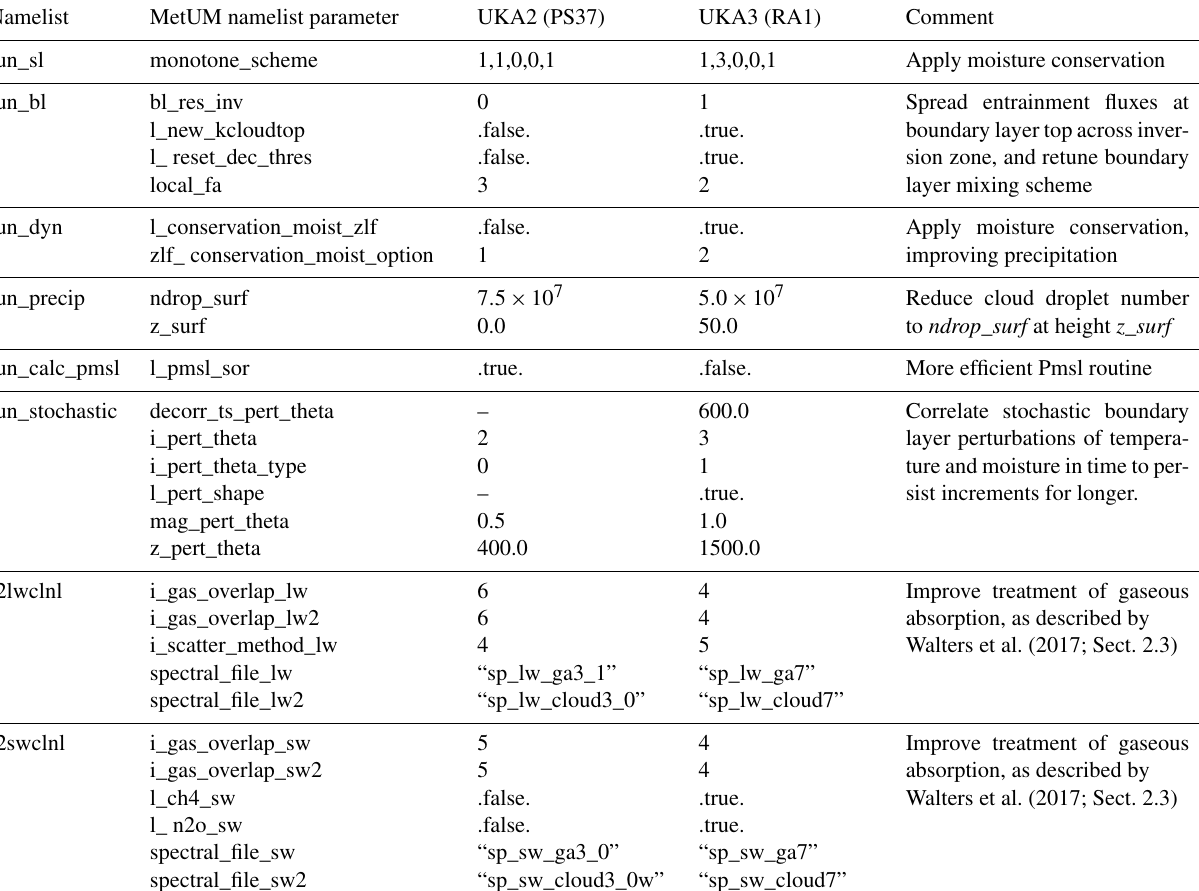
Table 5. Summary of key changes between UKA2 and UKA3 configuration MetUM namelists, associated with implementing enhanced science options based on regional atmosphere-only model development and evaluation. Registered MetUM users can access further details at https://code.metoffice.gov.uk/trac/rmed/wiki/ra1/protoRA1 (last access: 18 February